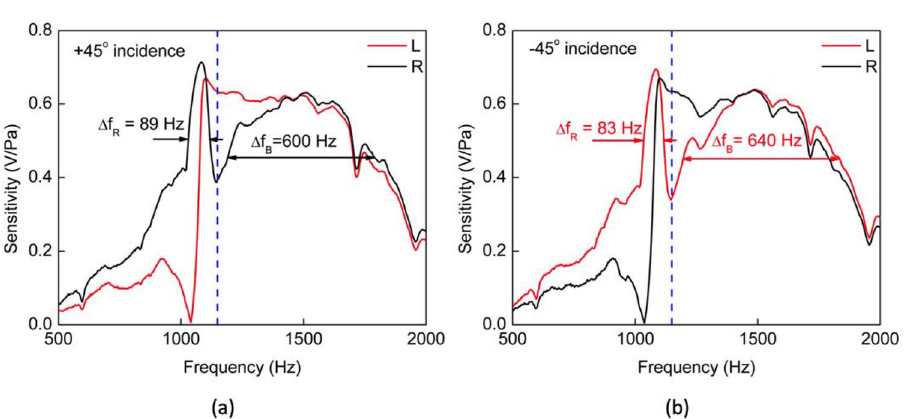
Figure 7. Electrically measured spectral responses. Electrical signal amplitudes obtained from each wing while the sensor was under swept-frequency acoustic excitation. Two angular orientations with respect to the incident wave were adopted: ( a ) + 45° and ( b ) − 45°. Reference system adopted is the same described on Fig. 3. Vertical blue dashed line locates the single tone frequency used in the directionality experiment (1150